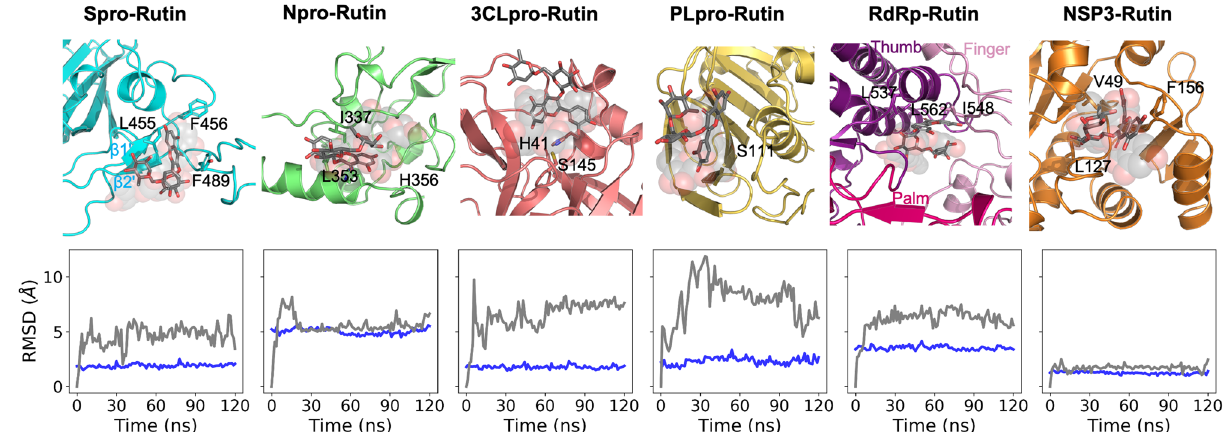
Figure 2. Cartoon illustration of rutin interactions with key SARS-CoV-2 proteins and the time evolution of RMSDs with protein alignment (blue plot: protein Ca atoms; grey plot: rutin heavy atoms). The RMSDs were calculated using the initial docking models as references. In the cartoon, the initial ligand positions (from docking) are represented as transparent spheres, and the final ligand positions (the final snapshot of the MD simulation) are shown as sticks. As the initial and final ligand positions largely overlap, it is shown that rutin stayed bound to the viral proteins through the simulations. The cartoon illustration was prepared in Pymol (version 2.3.4)